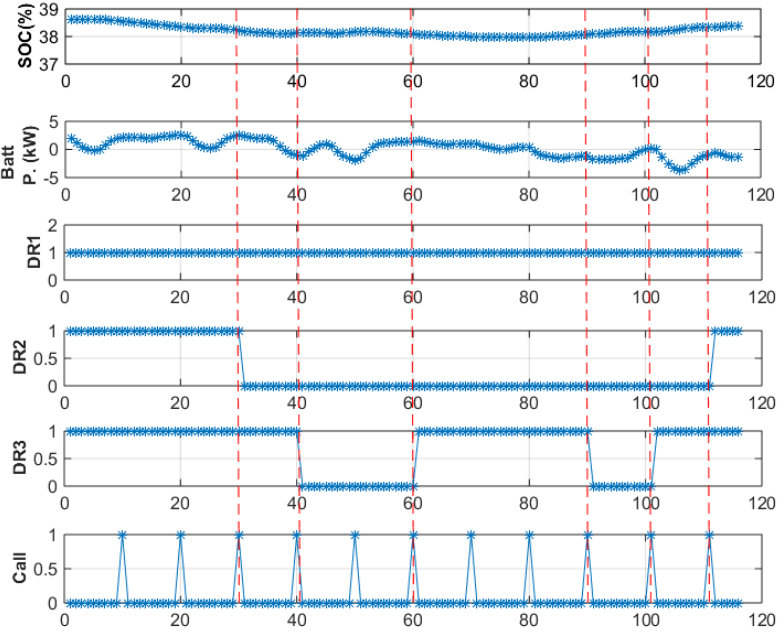
Figure 6. Input and output parameters of the fuzzy control function along with invocations of the call platform operation.